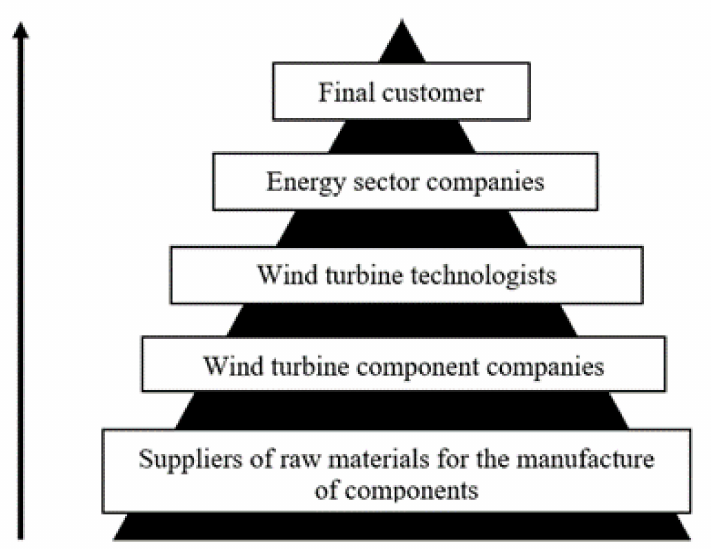
Figure 3. Value chain of the offshore wind energy